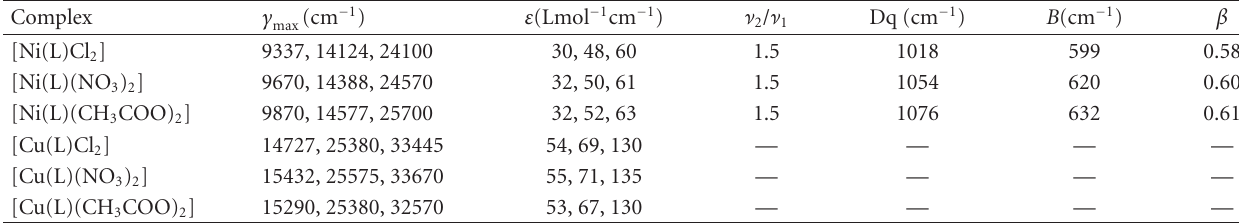
Table 3: Electronic spectral bands (cm − 1 ) and ligand field parameters of the complexes.